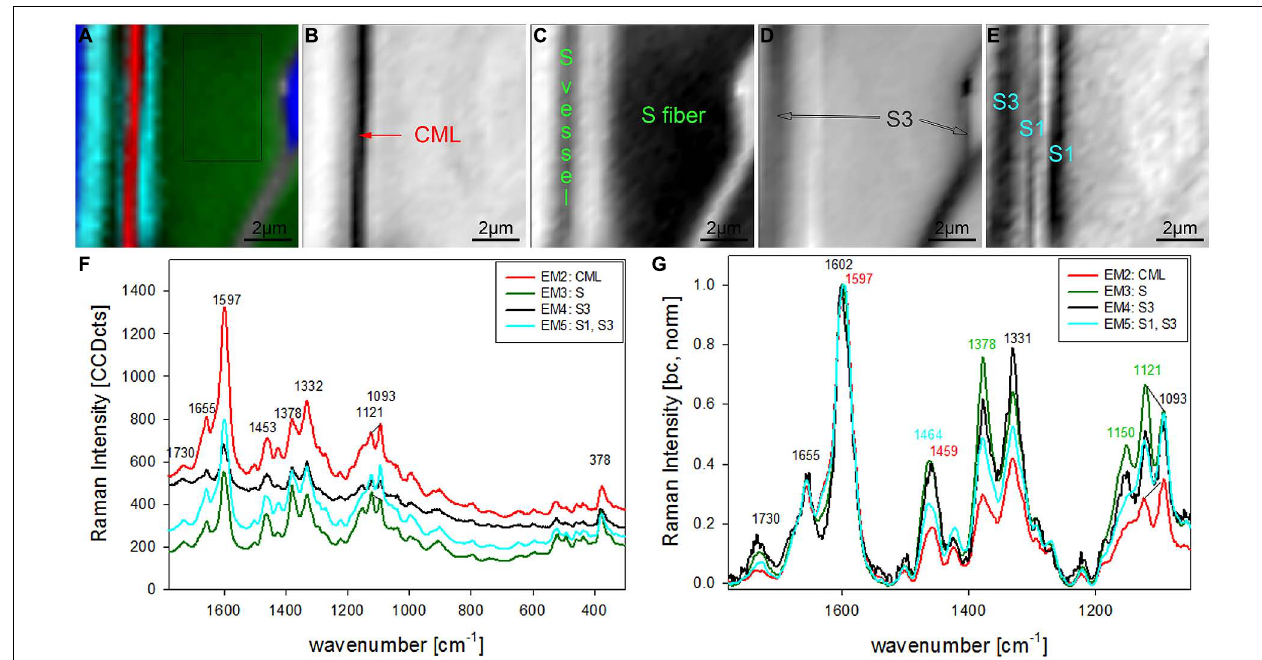
secondary cell wall (C), EM 4 with high intensity in the layers toward the lumen (S3; D), and EM 5 representing the S1 and S3 layer (E). The corresponding EM spectra are shown with original background and intensity (F) and after baseline correction and normalization on the aromatic stretching vibration at 1599 cm − 1 (G)